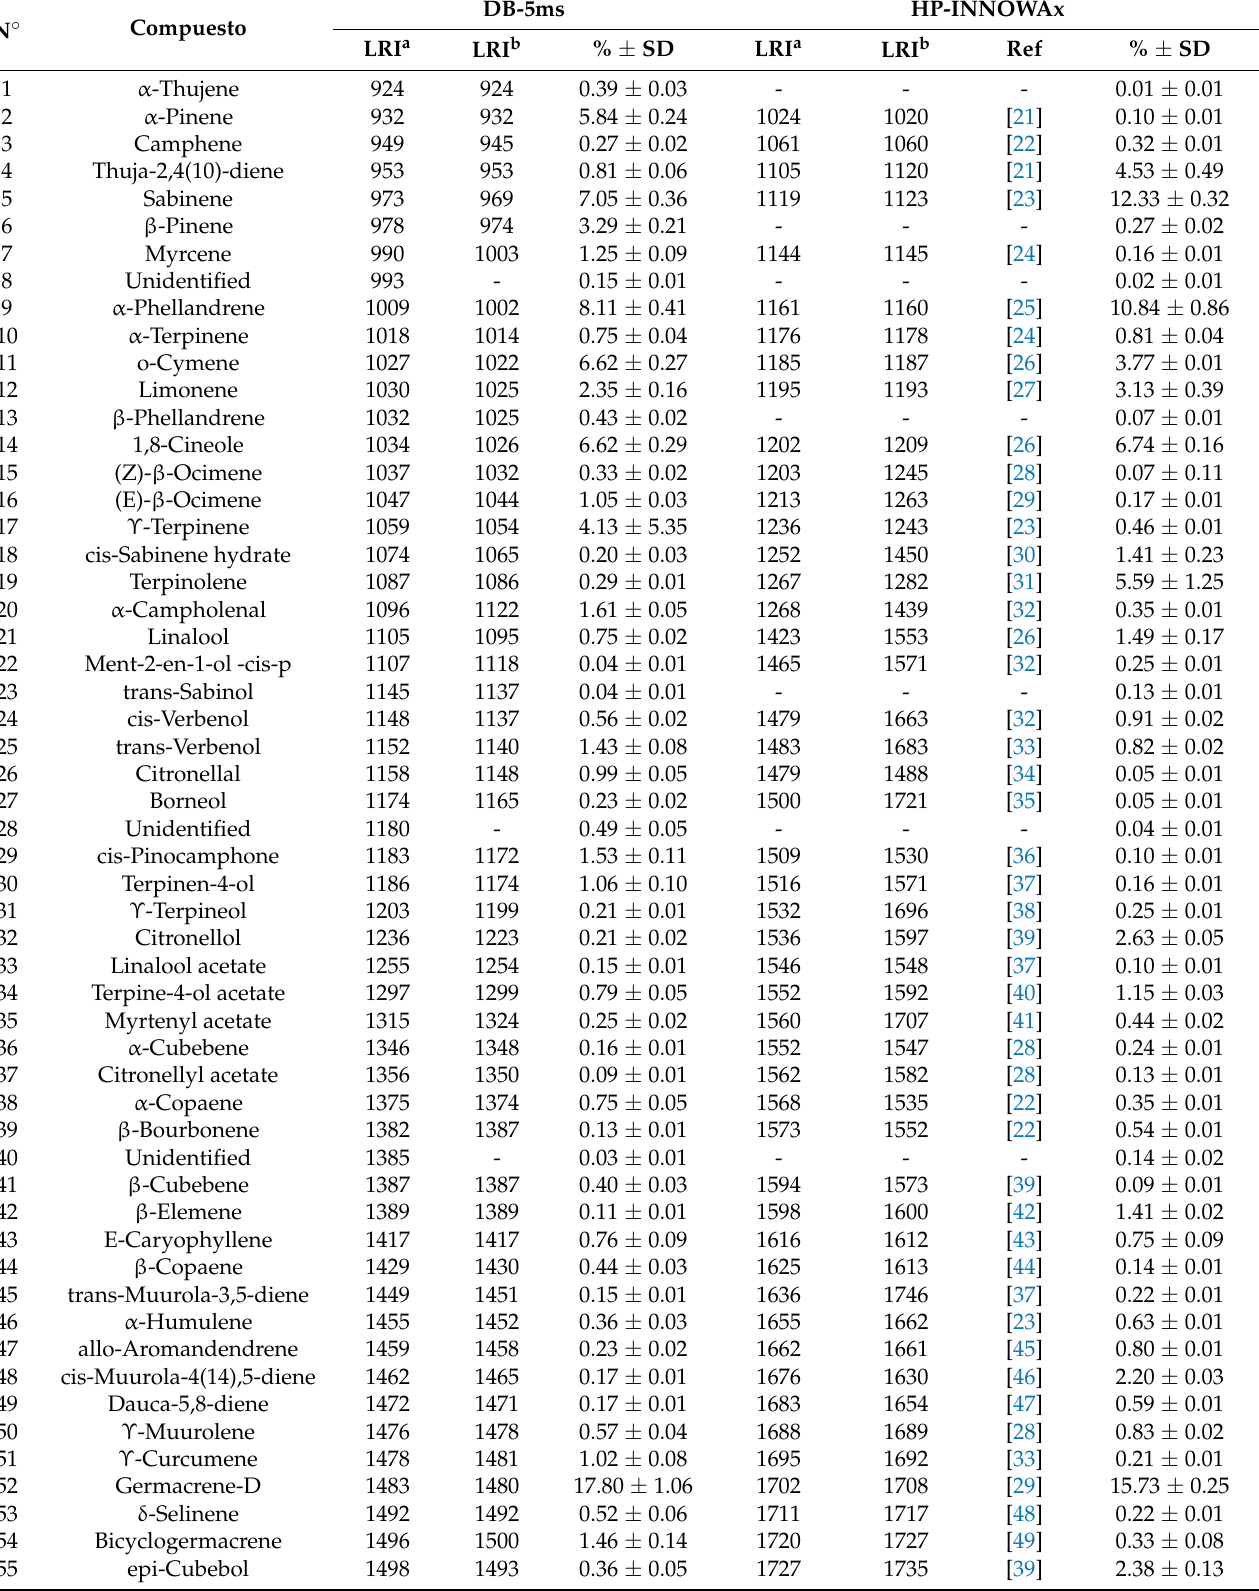
Table 1. Chemical composition of H. purpurascens EO in DB-5ms and HP-INNOWAx